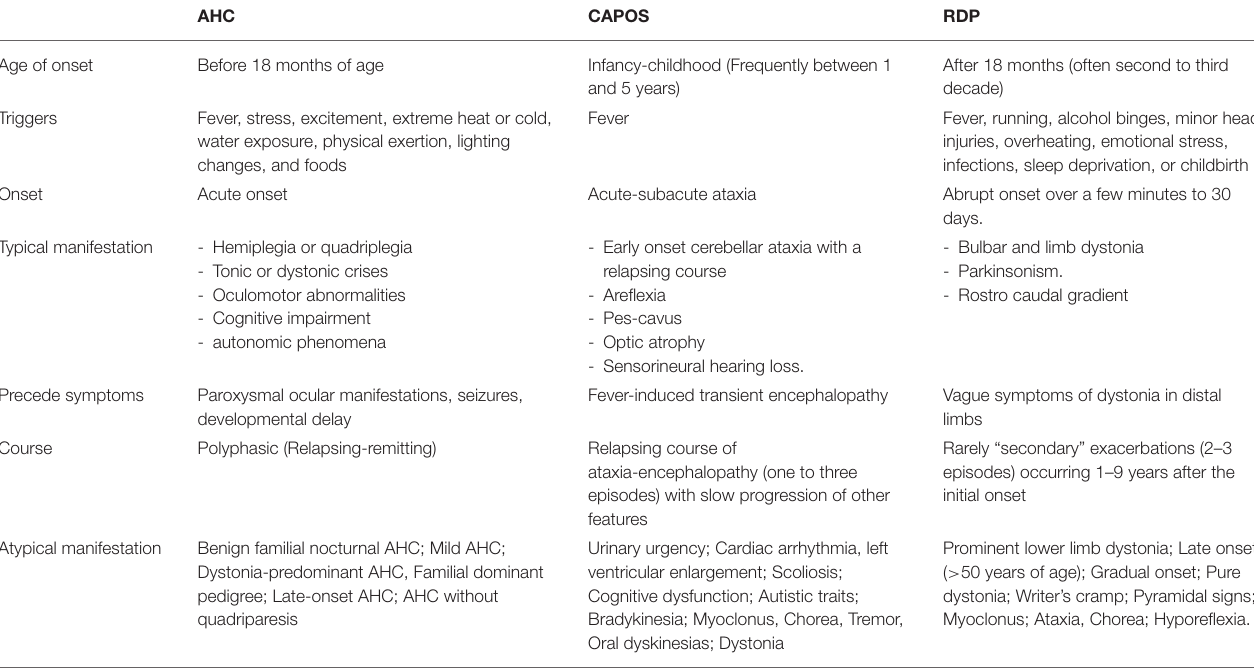
TABLE 1 | Clinical characteristics of ATP1A3 classical